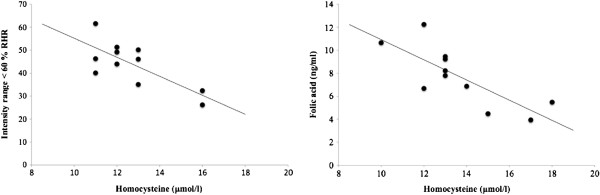
Relationship between homocysteine with other parameters in handball players.